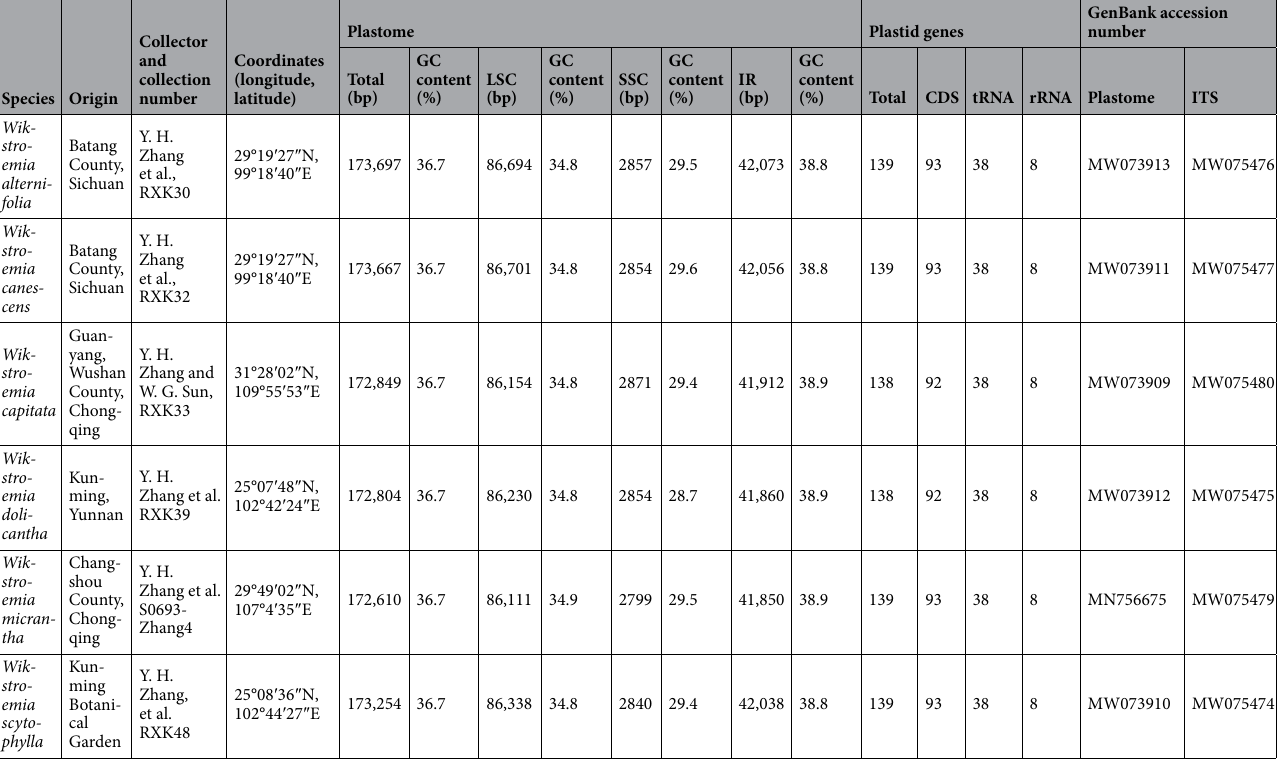
Table 1. Plastome features of six species of